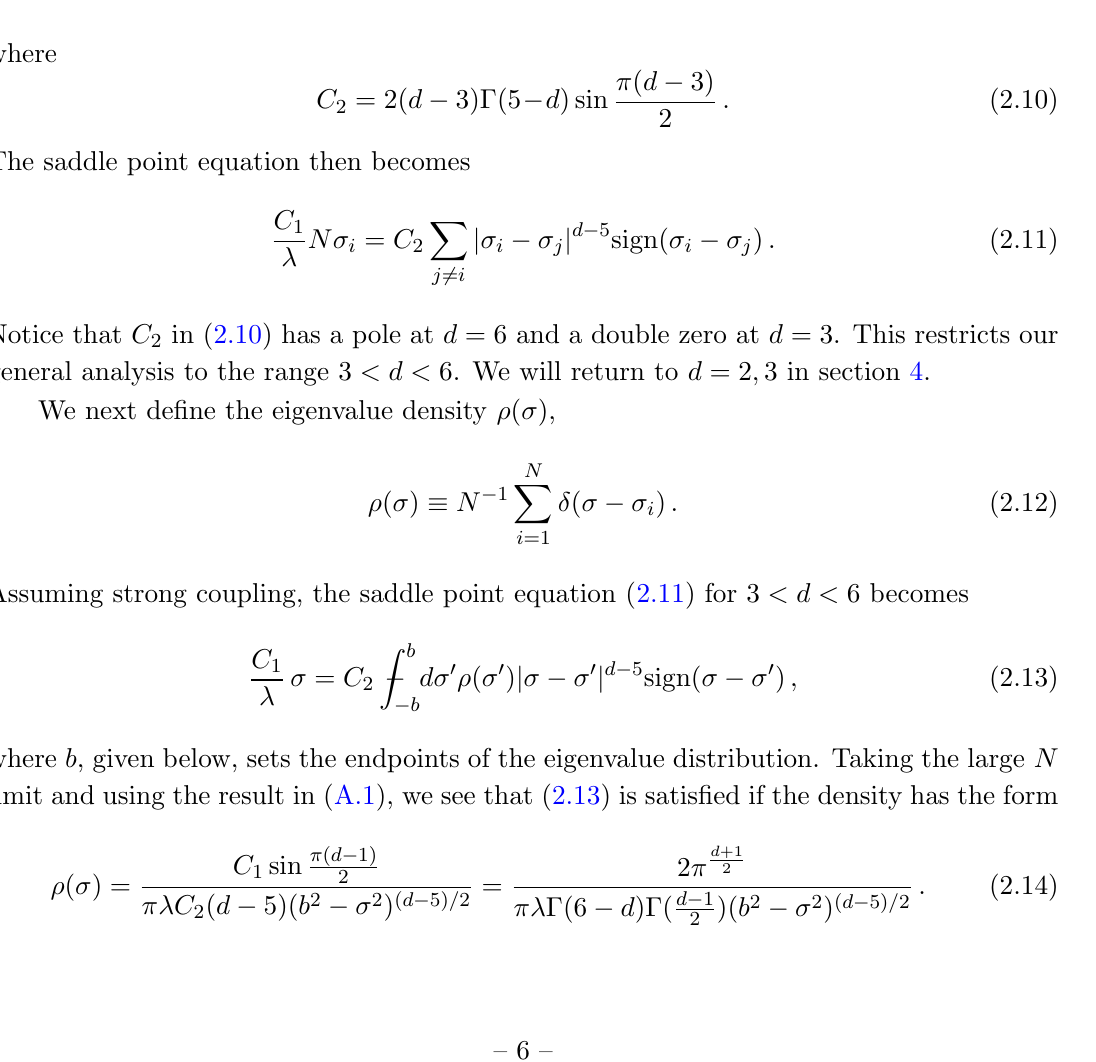
Figure 1 . The kernel G 16 ( (cid:27) ) for various values of d . For j (cid:27) j (cid:28) 1 the curves approach the same weak coupling behavior. For j (cid:27) j > 1 they approach di(cid:11)erent strong coupling